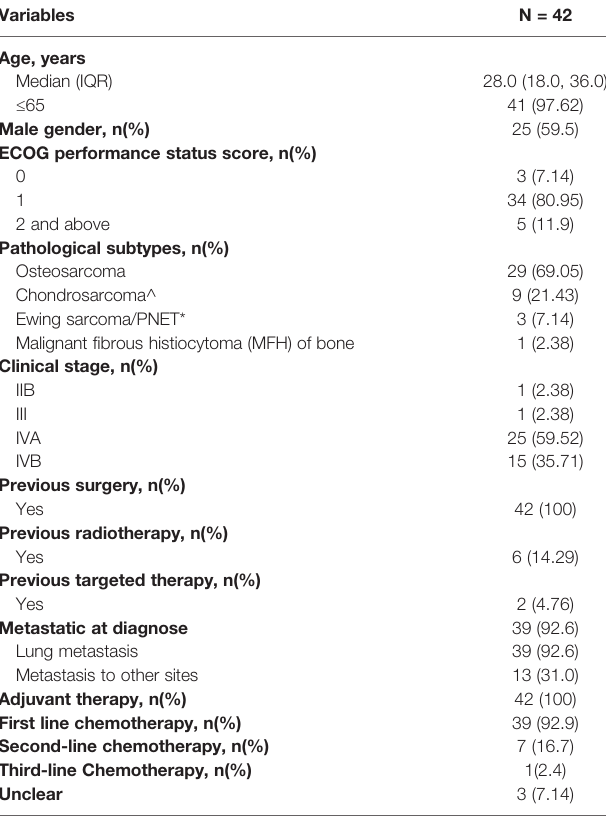
TABLE 1 | Patient demographic and baseline